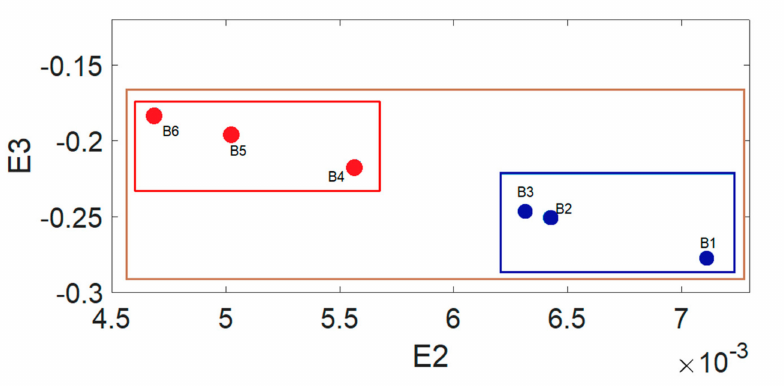
Figure 13. Area B classic domain and section domain.